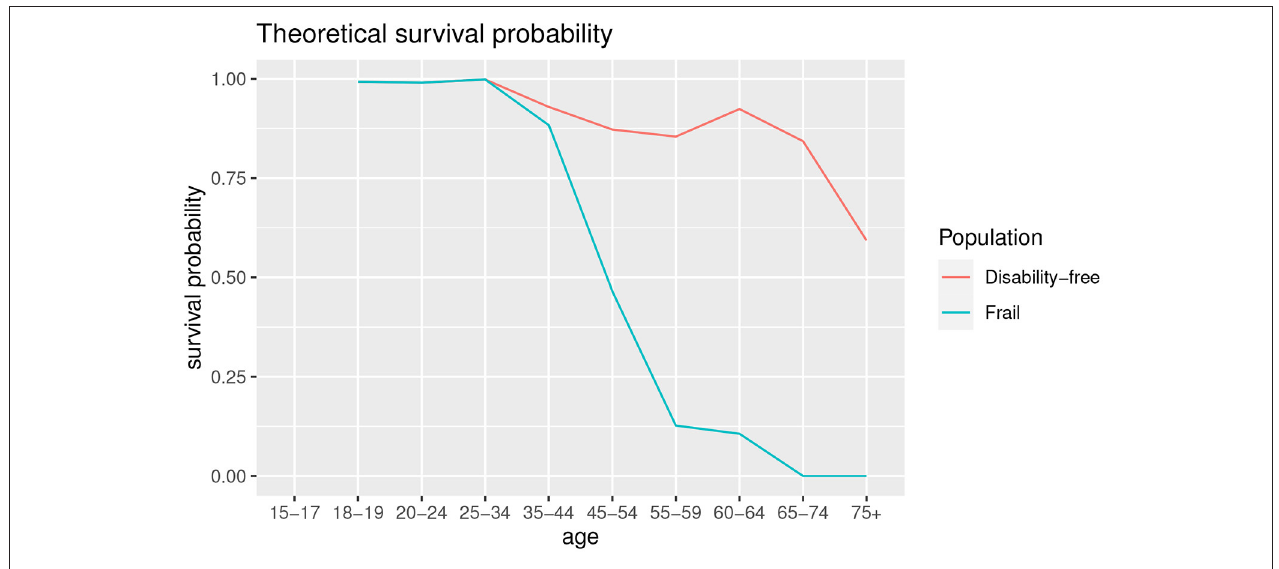
FIGURE 7 | Theoretical survival